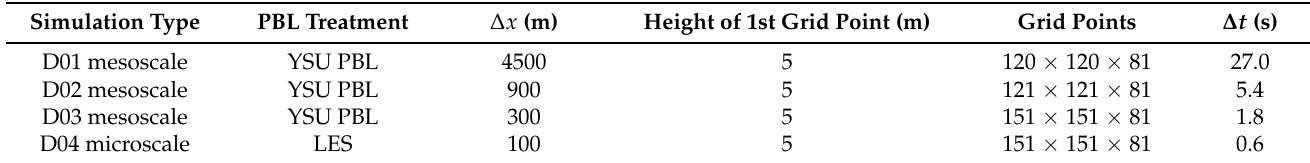
Table 3. The Yonsel University Planetary Boundary Layer scheme (YSU PBL) is used for mesoscale simulations [20]. Simulation